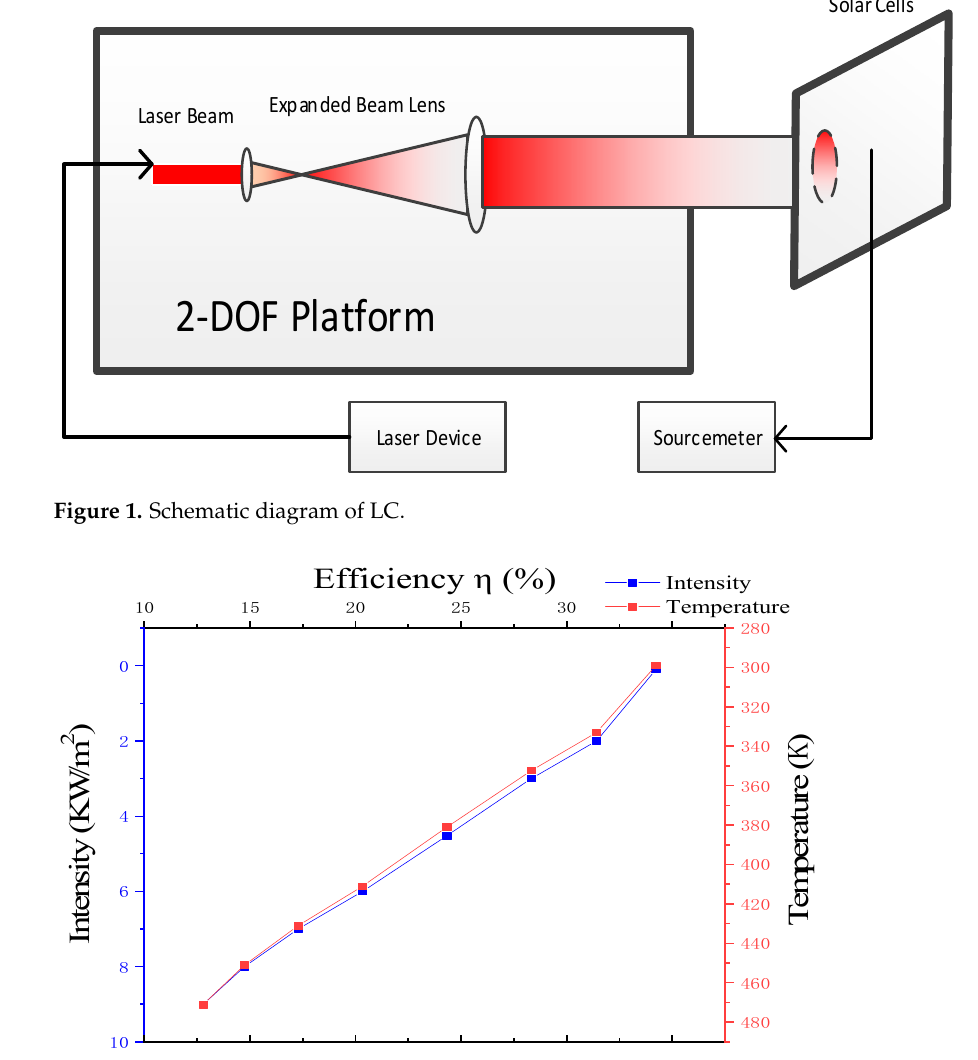
Figure 2. Efficiency curve under the different laser intensity and temperature.